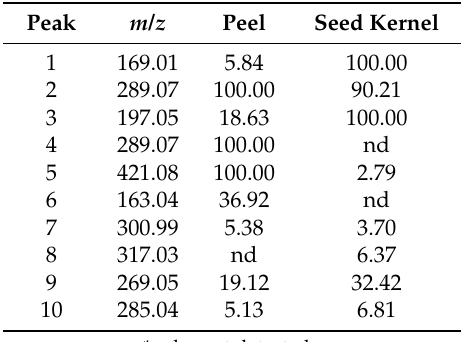
Table 6. Relative Abundance Values of TIC Peaks of Peel and Seed kernel from M. odorata . Peak m / z Peel Seed